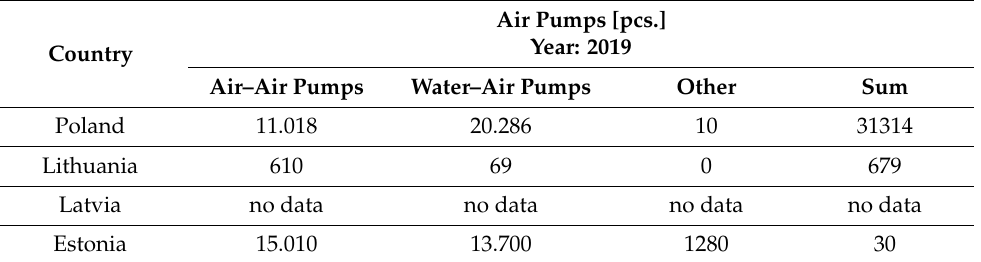
Table 4. Air source heat pump market in Poland and selected Baltic States in 2019 (sales/units summary)